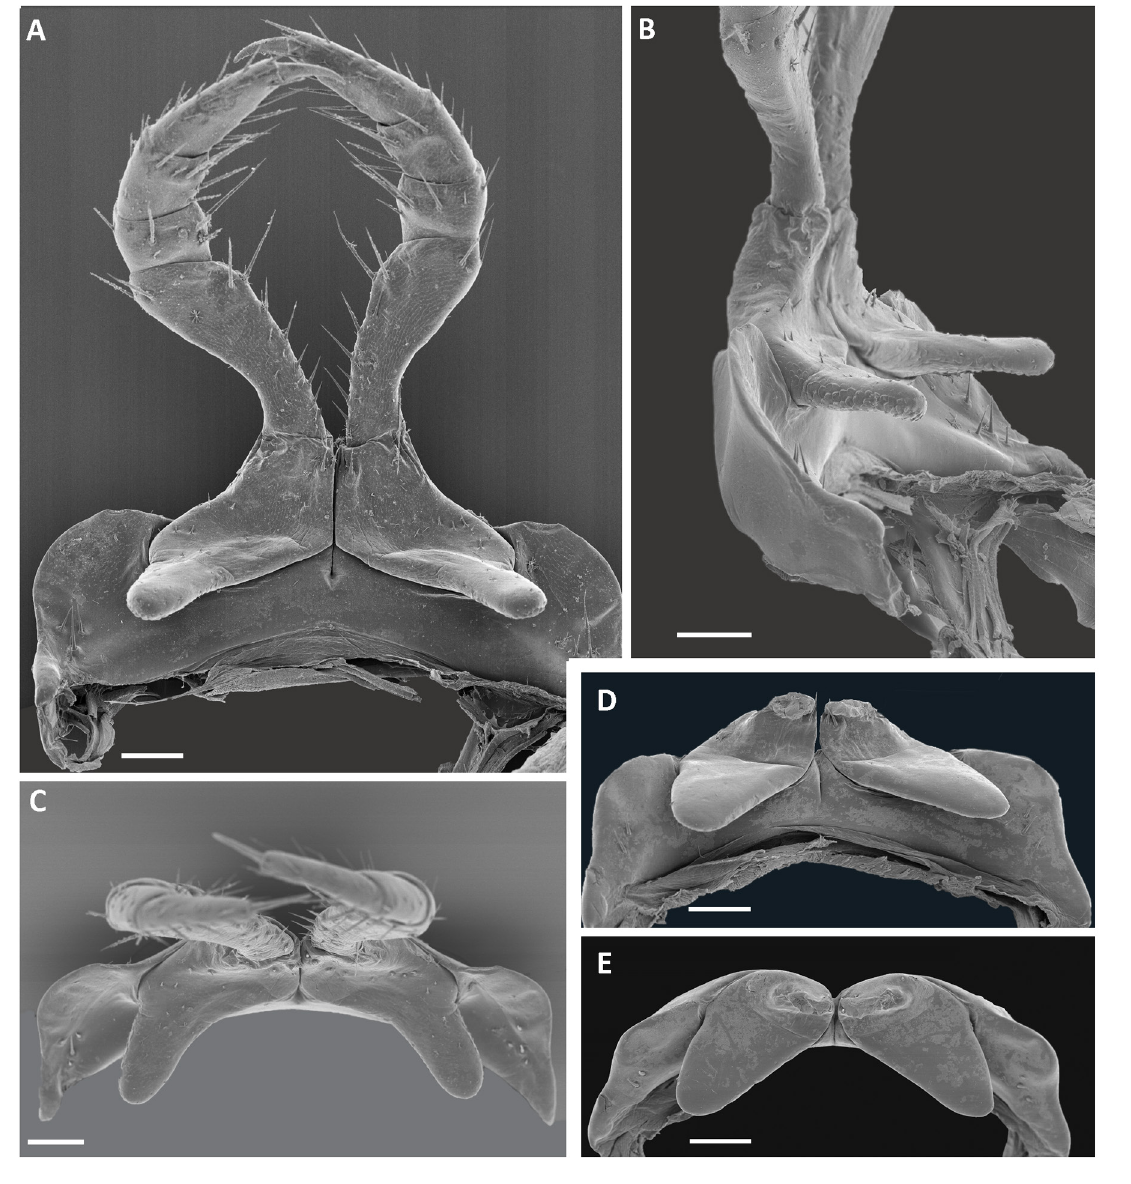
Fig. 7. Aquattuor spp., first pair of male legs. A – C . A. submajor Enghoff, 2015, paratype, ♂ (NHMD 621651). A . Anterior view. B . Sublateral view. C . Ventral view. D – E . A. udzungwensis Enghoff, 2015, male from Udzungwa Mts National Park, Kidatu (NHMD 621662). D . Anterior view. E . Ventral view. Scale bars = 0.1